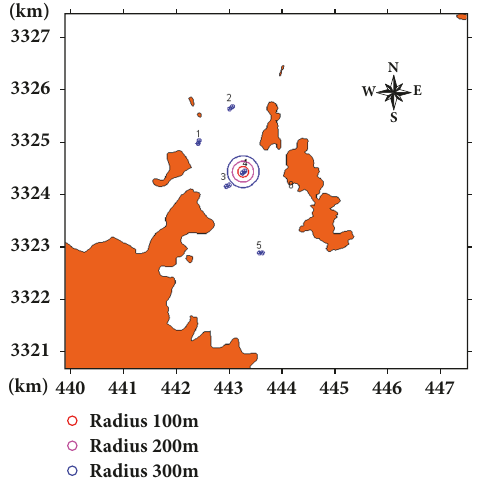
Figure 12: Exploratory circumference schematic.